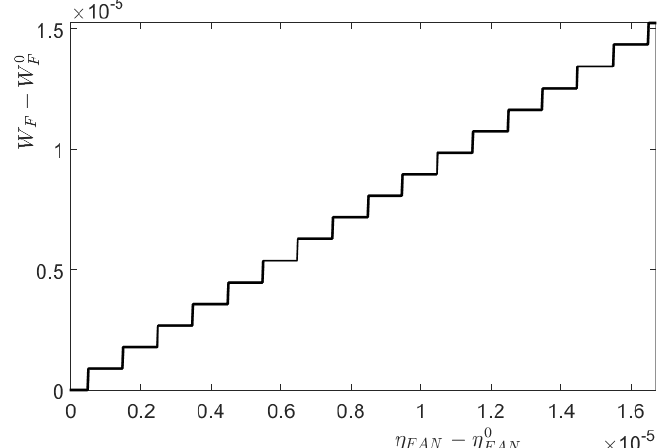
Figure 4. The output of the 10th sensor, W F , vs. the first (input) degradation, η FAN (both defined in Table 1), as computed by the PROOSIS solver for constant values of the remaining inputs. The values = 0.88000 and W 0 = 0.83844 are subtracted from the inputs and outputs, respectively, thus η 0 F FAN plotting W F − W 0 vs. η FAN − η 0 , which are both very small, ∼ 10 − 5 . The scale numbers appearing F FAN in both the ordinate and abscissa axes are multiplied by 10 − 5 , as